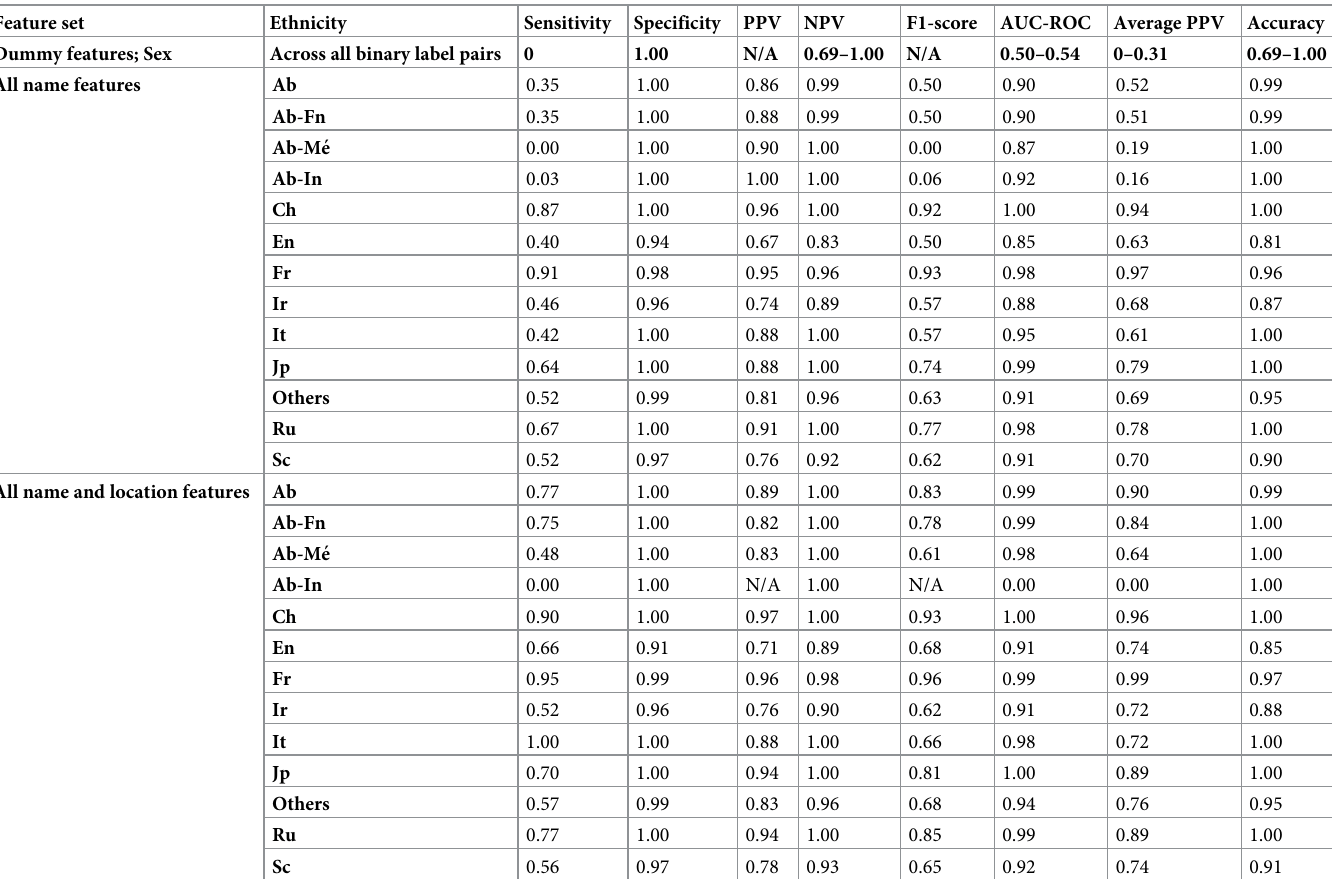
Table 7. Binary classification predictive performance in test set based on C-support vector classifiers trained in training set. Feature